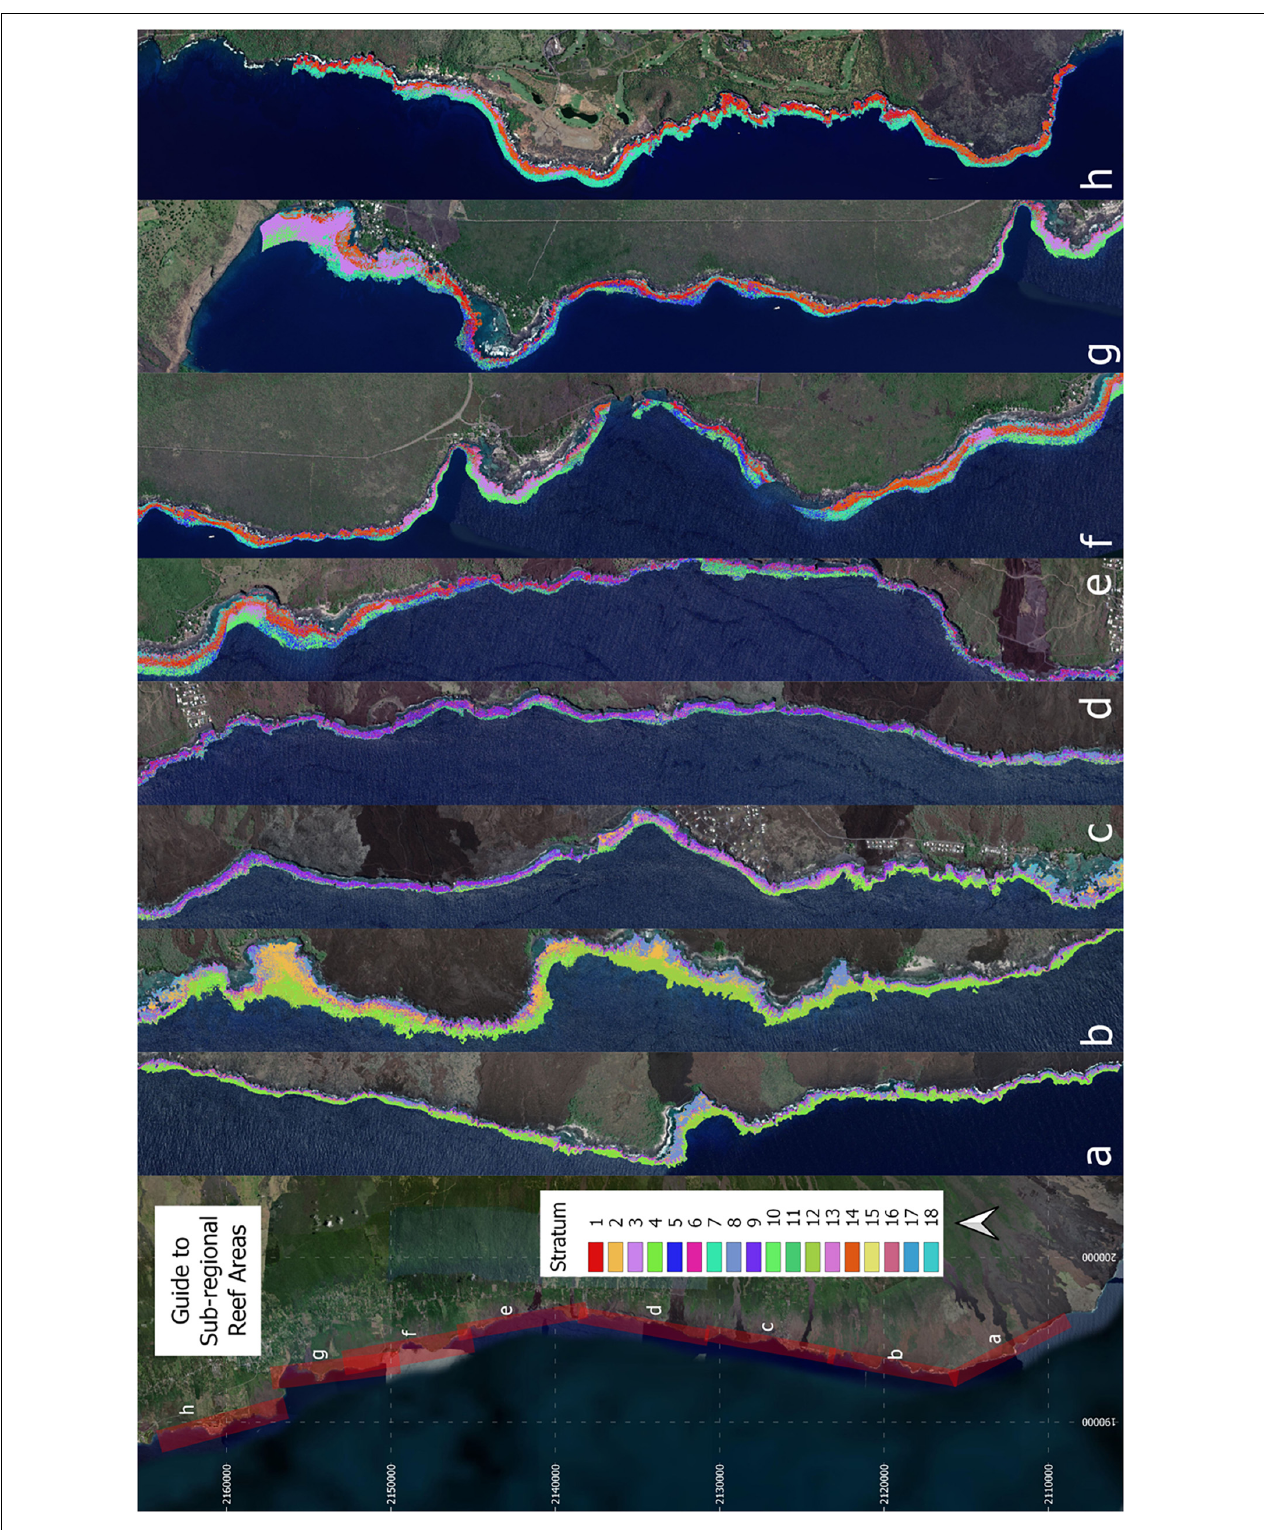
FIGURE 6 | Final 18-stratum map of coral reef conditions for the coast of South Kona District. The far left panel indicates the location of each sub-regional zoom image (a–h) shown in the remaining panels. Each color indicates the location of each ecological stratum in the reef system. Background imagery retrieved from Google, ©2021 Maxar